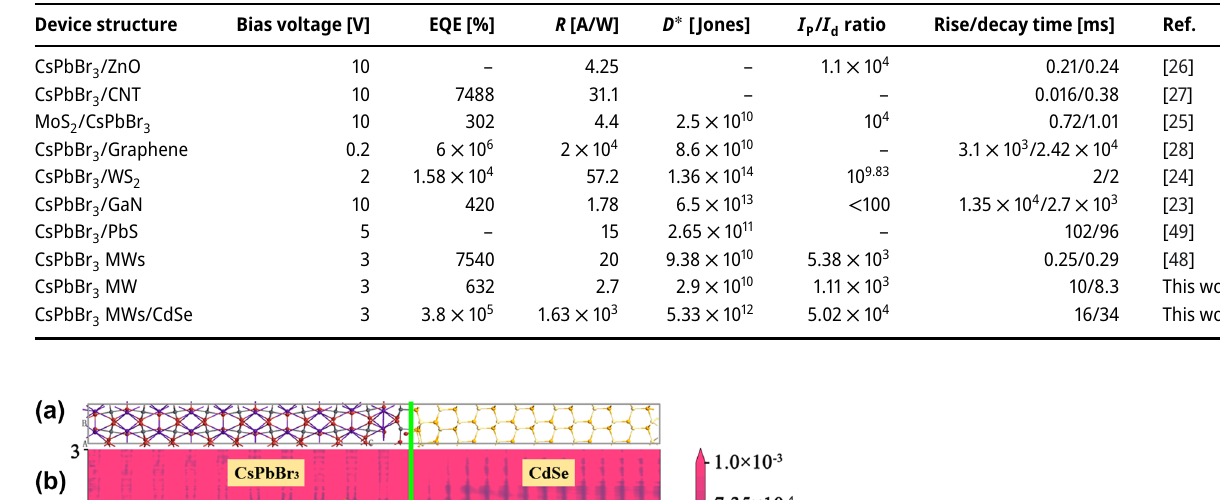
Figure 7: I − T characteristic curves of CdSe NB/CsPbBr under incident light of 530 nm with bias voltages of 1 V, 3 V, 5 V, and 7 V, respectively. (b) Rising and falling edges in a single cycle at a bias voltage of 3 V. Table 1: Comparison of performance parameters of CsPbBr 3 -based photodetector device.